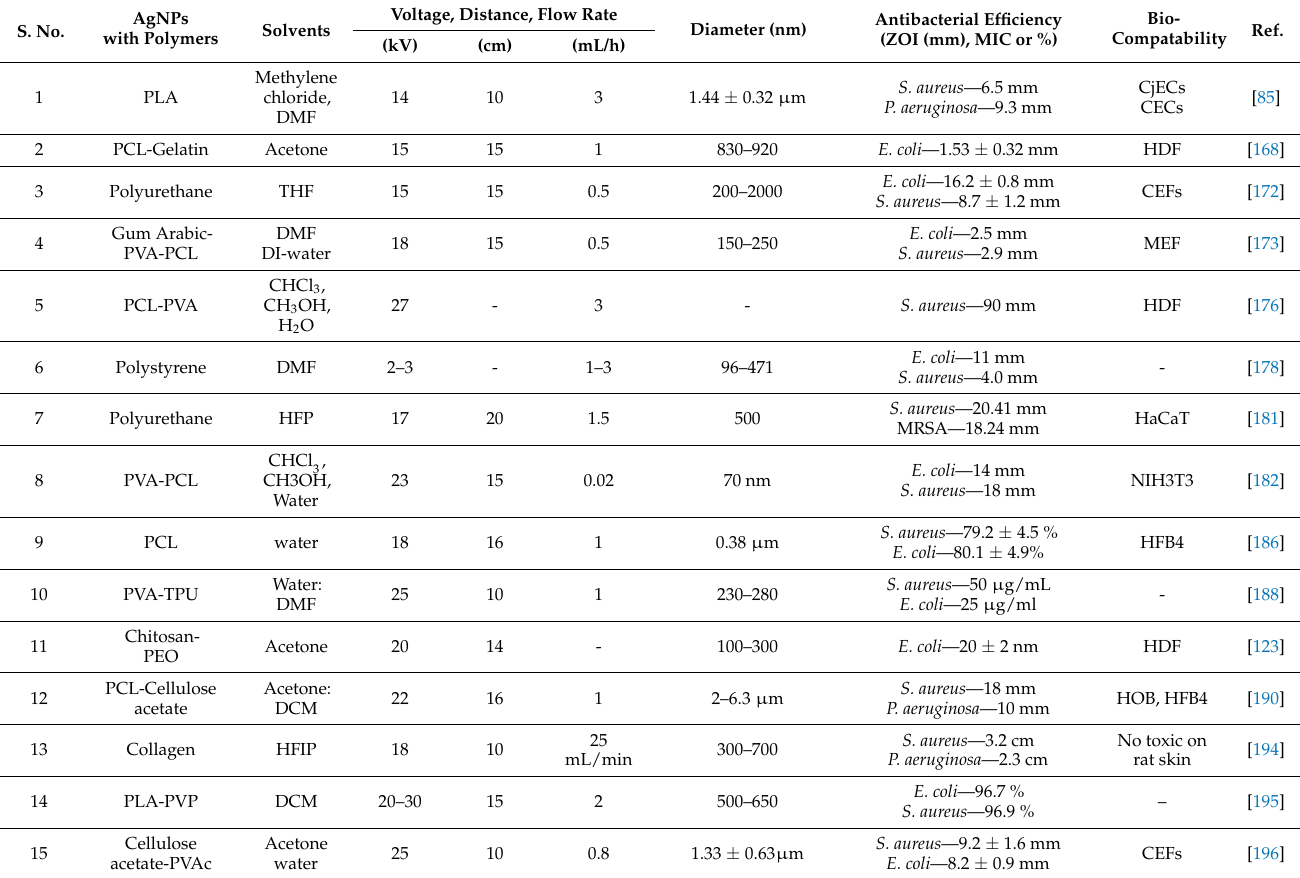
Table 4. Incorporation of silver nanoparticles into electrospun nanofibers for wound healing.